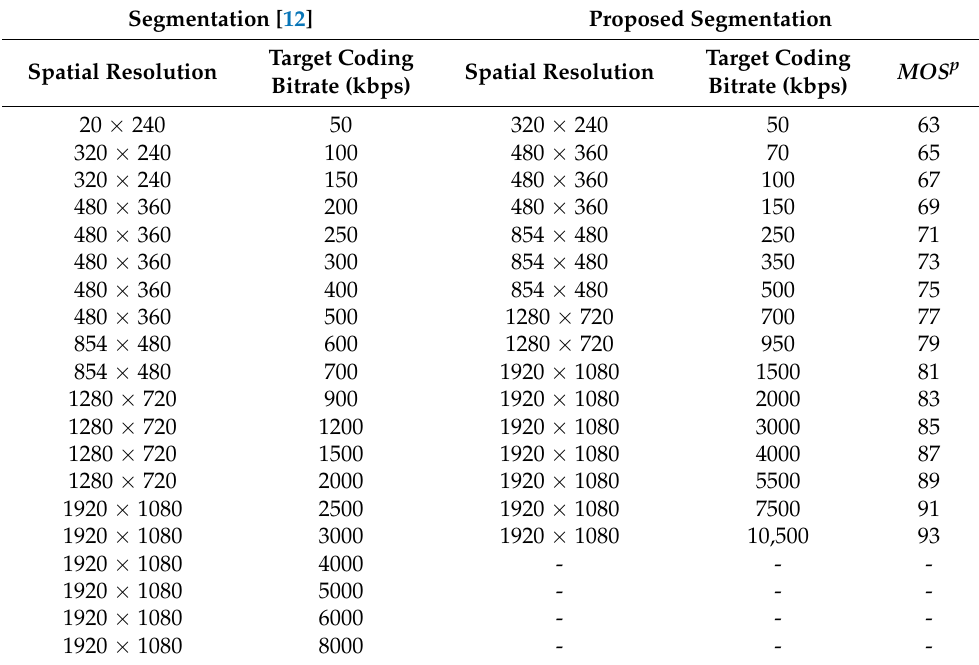
Table 7. Parameters for representation sets for the BBB video sequence from [12] and for the pro- posed